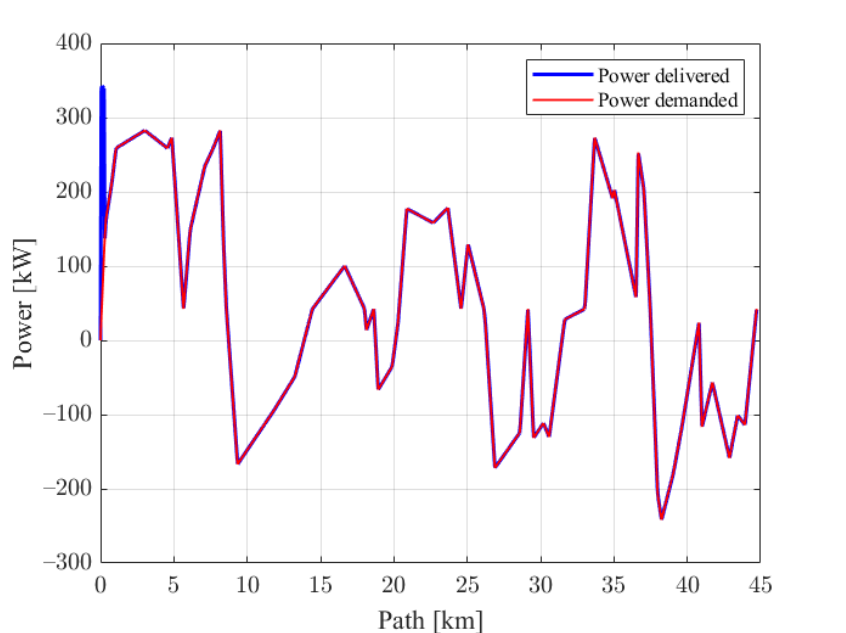
Figure 12. Overall power demanded and delivered over the entire route.